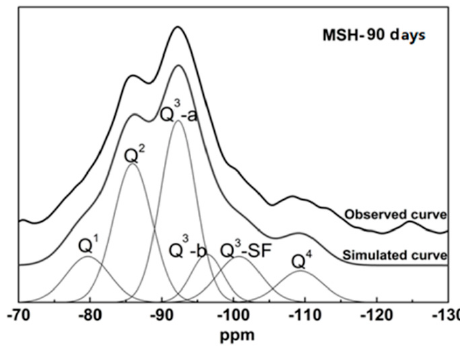
Figure 5. 29 Si MAS NMR spectrum of the MSH-90 days sample and the optimum de-convolution result.